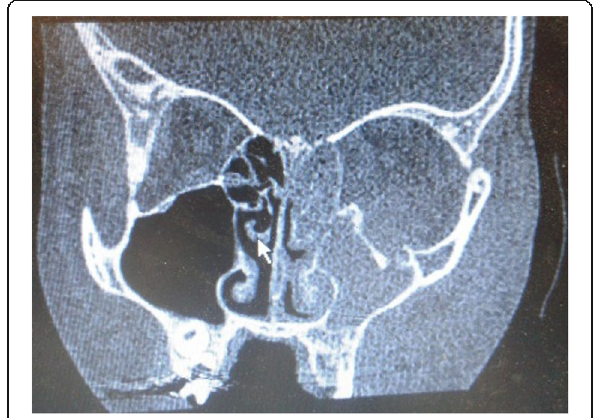
Fig. 1 Inferior orbital cellulitis secondary to blow out fracture, Orbital CT scan coronal view revealed inferior wall fracture with total opacity of the left maxillary and ethmoid sinuses